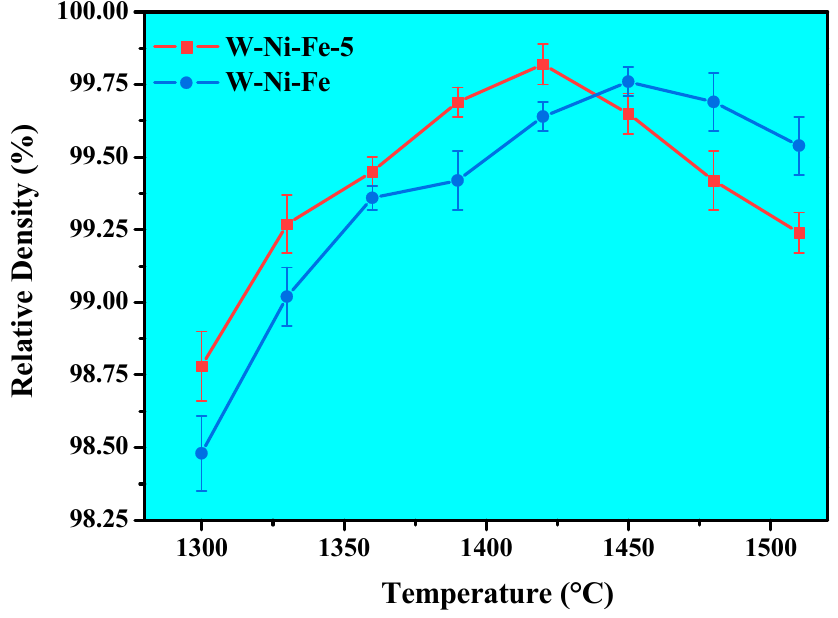
Figure 7. Sintering relative density changing with sintering temperature. As is depicted in Figure 8, the tensile strength of the two kinds of powders varies with sintering temperature, it shows that both firstly increase with sintering temperature, with the W-Ni-Fe-5 reaching its maximum tensile strength at 1420 ◦ C and W-Ni-Fe reaching its maximum tensile strength at 1450 ◦ C, which are 781 MPa and 725 MPa, respectively, then both of which decrease as the temperature continues to rise. The tensile strength of sintered W-Ni-Fe-5 is always higher than that of W-Ni-Fe, this shows that the ball milling treatment not only has effect of promoting sintering densification, but also improving the mechanical